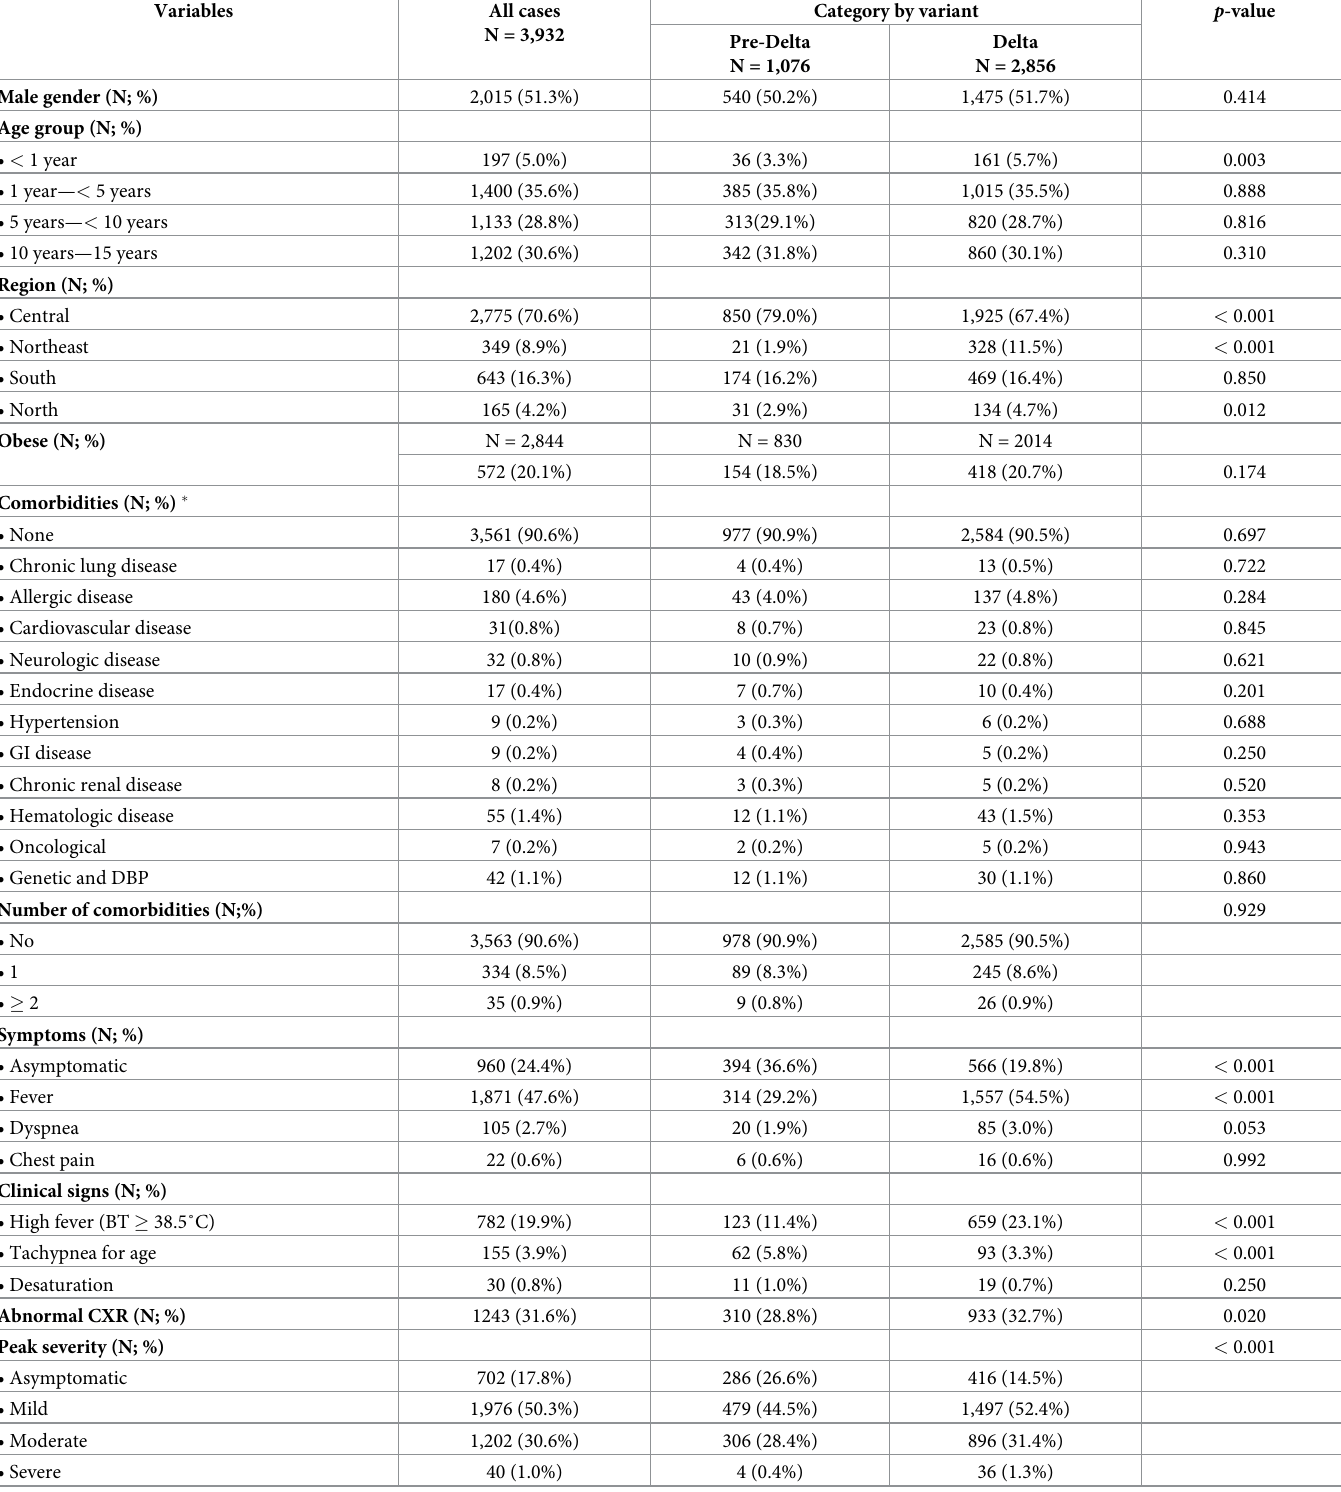
Table 1. Demographic data and clinical characteristics in different periods of 3,932 confirmed pediatric COVID-19 cases.